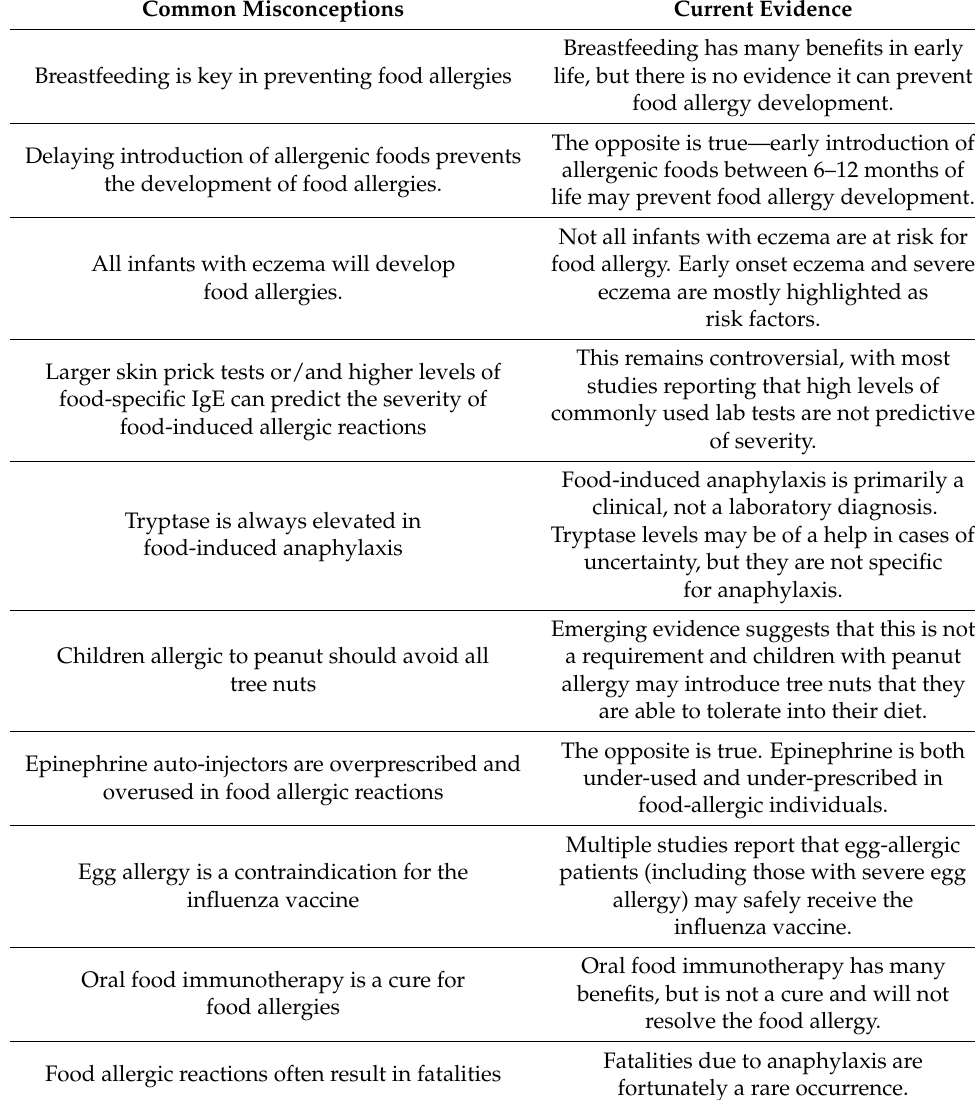
Table 1. Common misconceptions in food